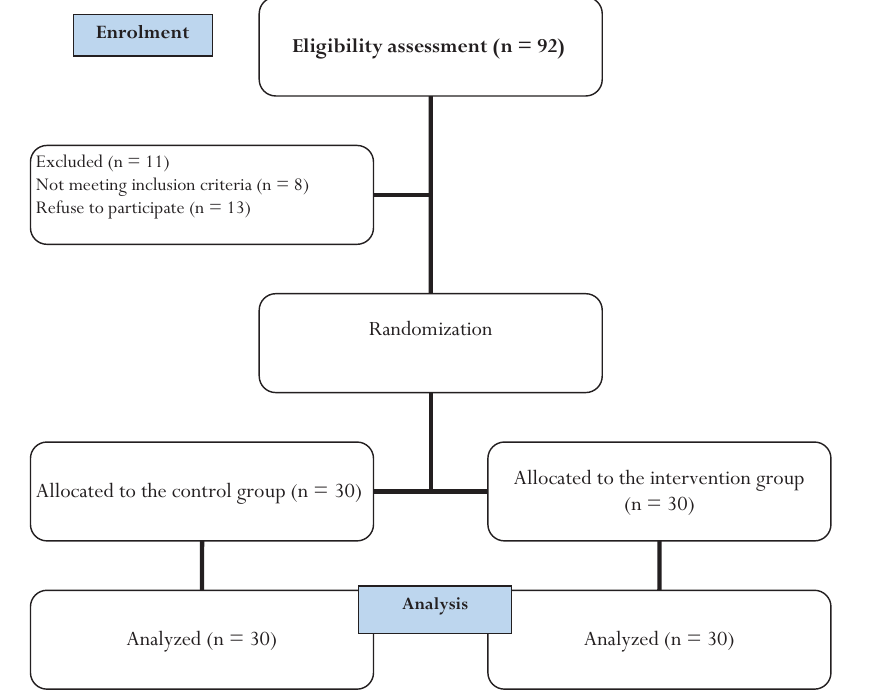
Figure 1. The flow diagram of the